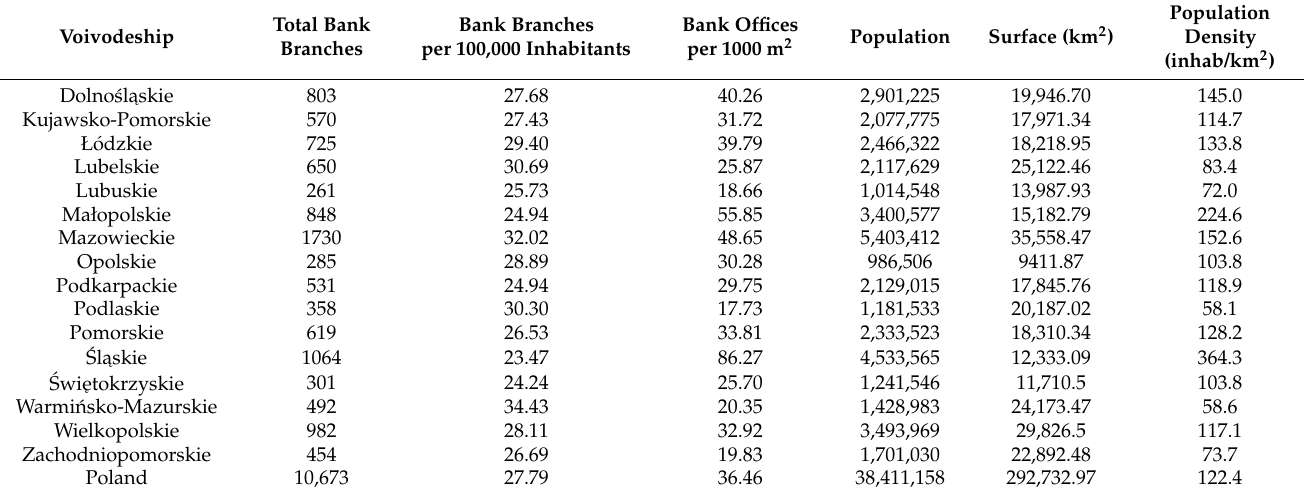
Table A1. Total bank branches, bank branches per 100,000 inhabitants and bank branches per 1000 m 2 for each voivodeship, population, surface and density.